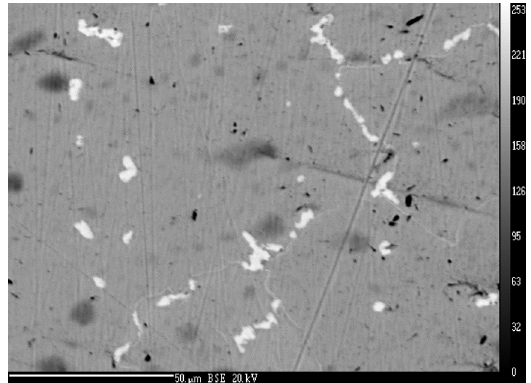
Figure 1: Backscattering electron micrograph of as-cast 52Ti-12V- 36Cr+4%wt.Zr